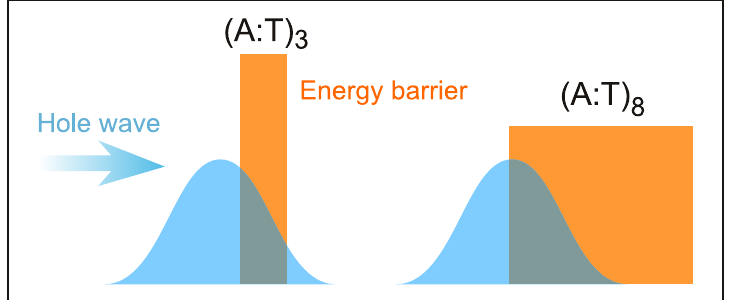
Figure 12. The contrasting effects of the bridge in the HT for the sequences studied by Giese: In short sequences ( left ), superexchange is favored by the short tunneling distance and disfavored by high barriers. In longer sequences ( right ), barrier height decreases due to formation of delocalized A • + n polarons thus favoring the HT, but tunneling distance increases, thus attenuating the efficiency of HT at the same time.